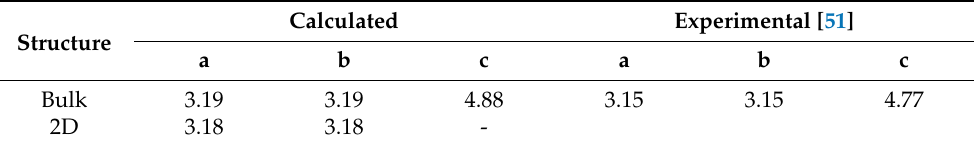
Table 1. Lattice parameters of bulk and 2D Mg(OH) 2